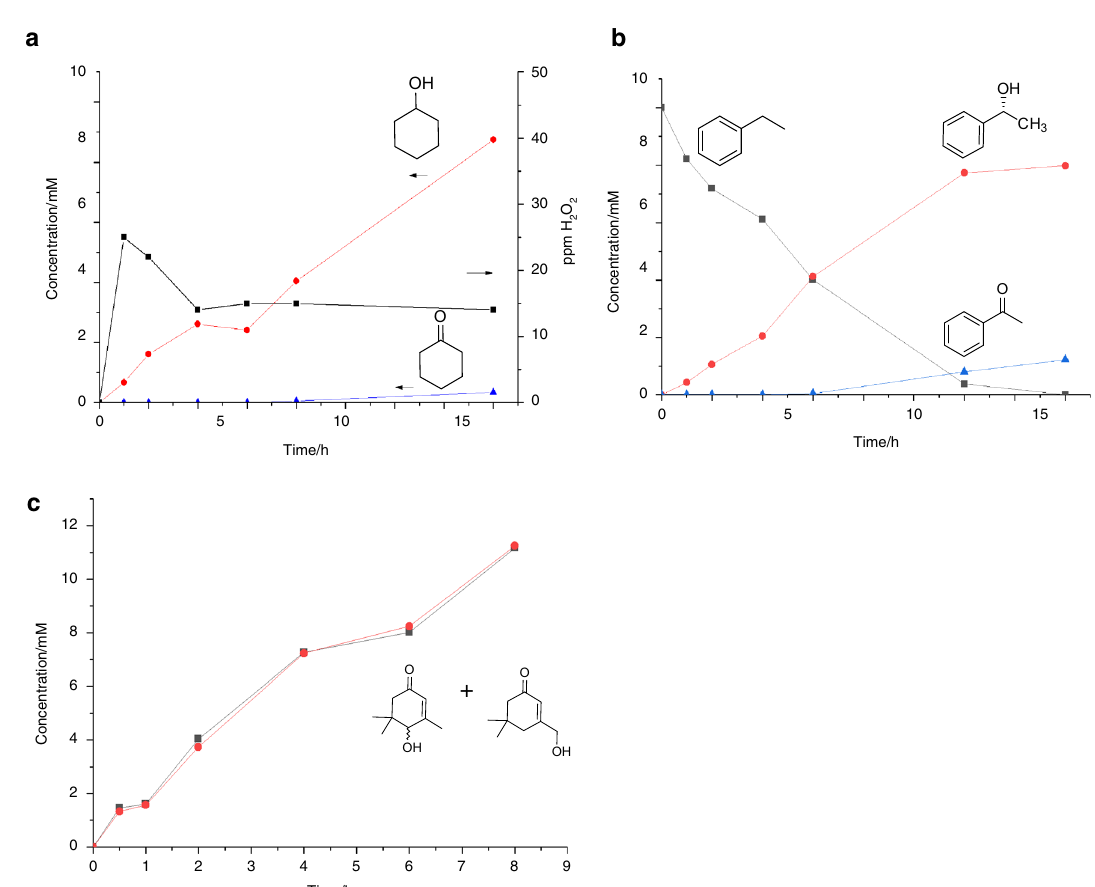
Fig. 3 Hydroxylation reactions using tandem catalysis system. Time on line hydroxylation reactions of a H 2 O 2 production (black squares) (in the absence of enzyme) and cyclohexane (10 mM) oxidation to cyclohexanol and cyclohexanone b Ethylbenzene (10 mM) oxidation to 1-phenylethanol c Isophorone (30 mM) oxidation to 4 and 7-hydroxyisophorone when PaDa-I (15 U ml RM − 1 ) was coupled with in situ H 2 O 2 generation by 0.5% Au-0.5% Pd/TiO 2 (0.1 mg ml RM − 1 ) using a gas mixture of 80% H 2 in air in a sealed system under 2 bar total